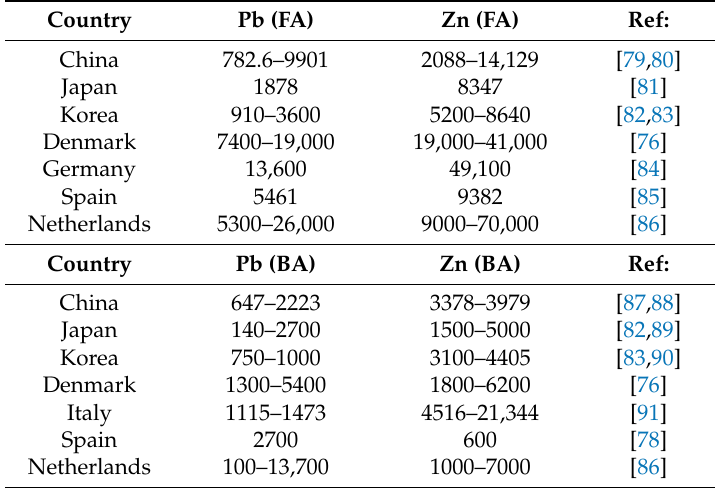
Table 6. Heavy metal Pb and Zn content (mg / kg) in MSWI fly ash (FA) and MSWI bottom ash (BA).